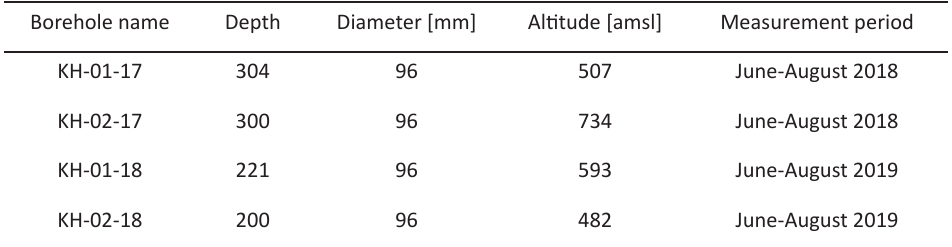
Table 1. Data for the boreholes considered in this study from Elvebakk & Pless (2018).